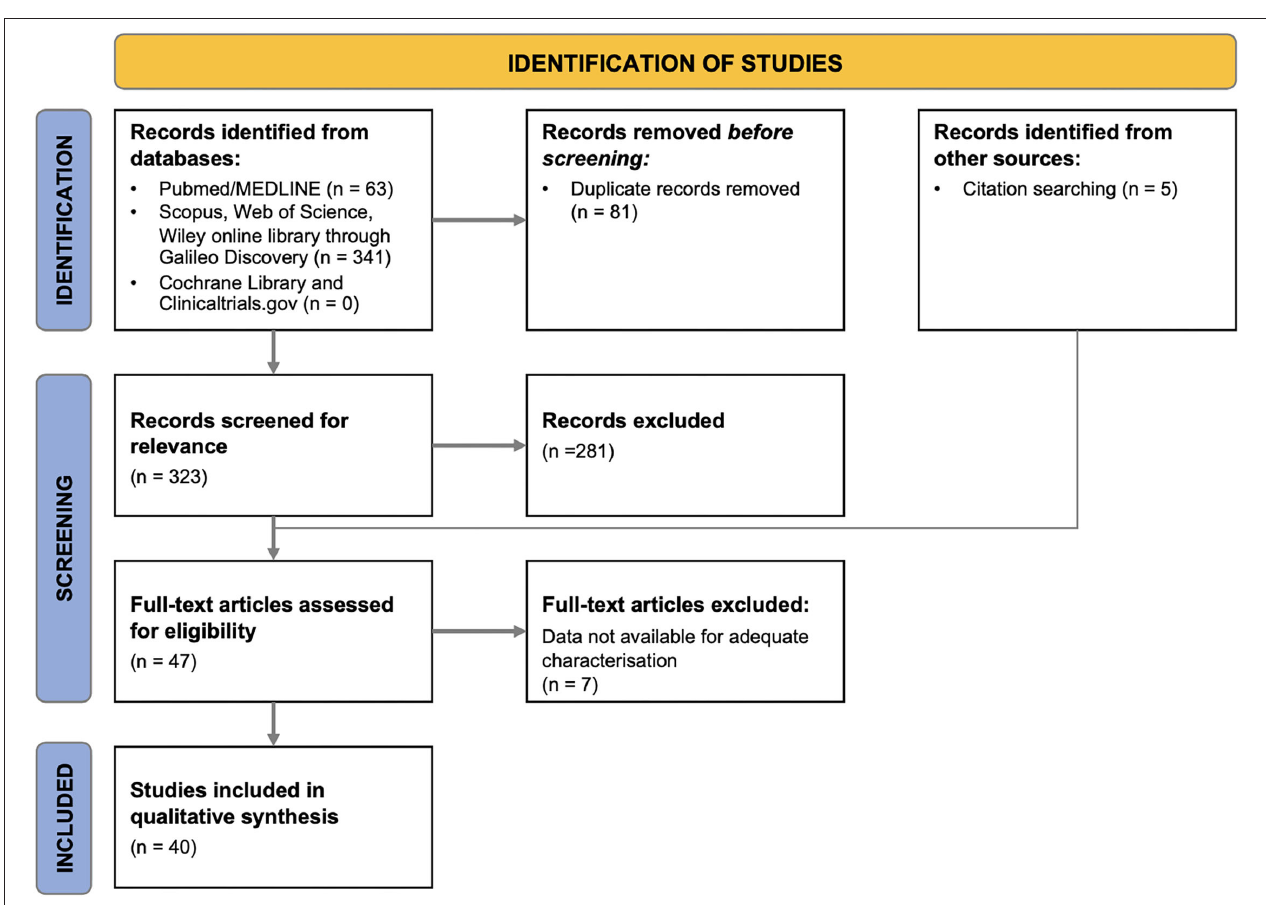
FIGURE 1 | PRISMA flow diagram of the search strategy and included